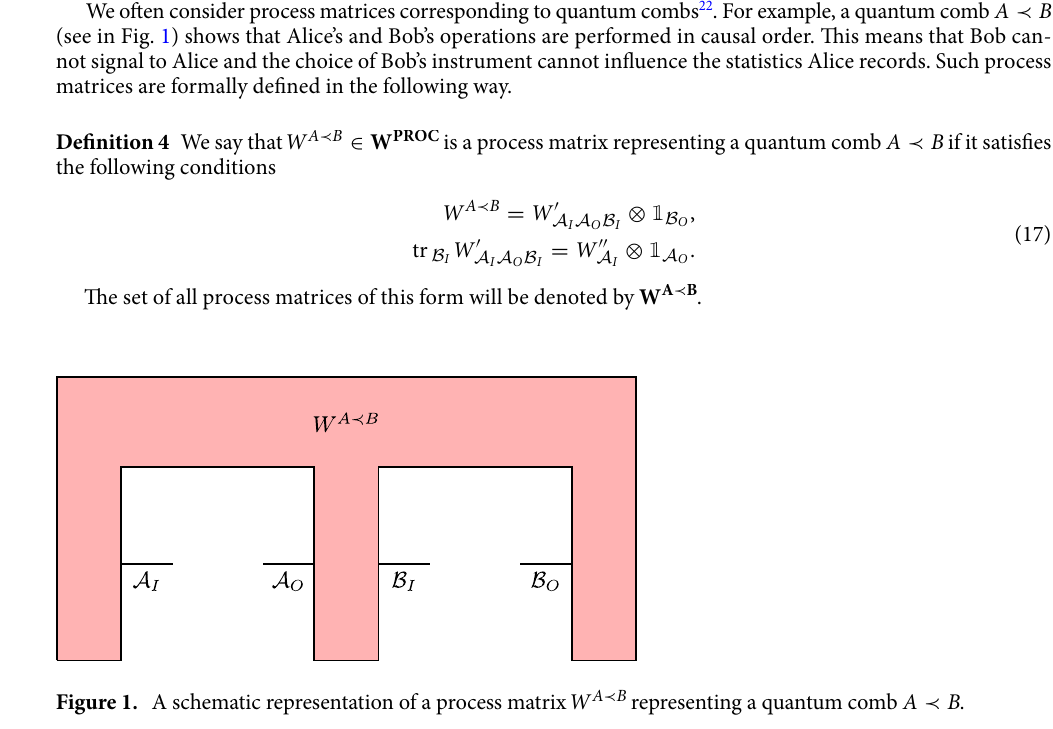
Figure 1. A schematic representation of a process matrix W A ≺ B representing a quantum comb A